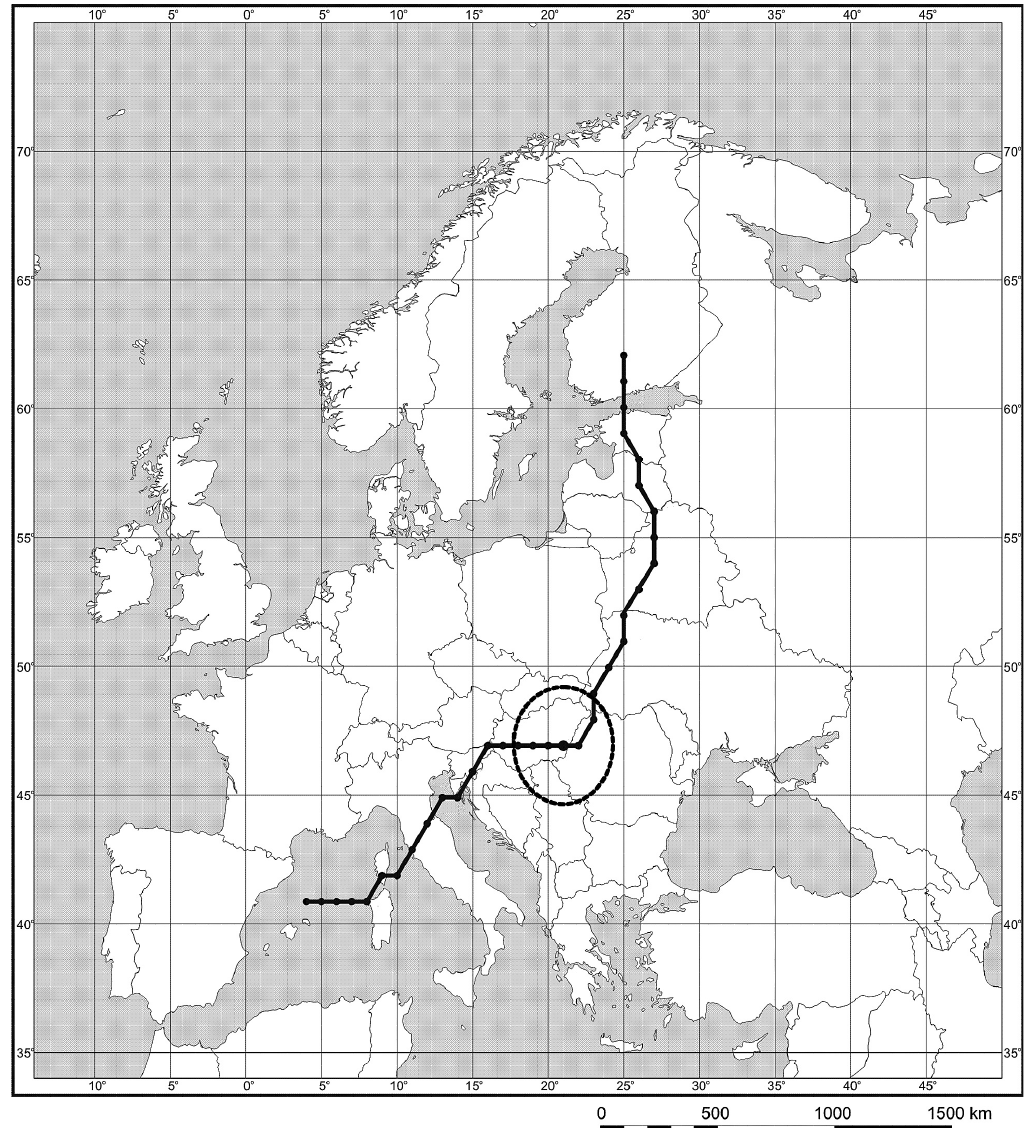
Fig. 3. Mean position of the track Vb of Mediterranean cyclones (MEC). Positions of cyclones involving the highest MCP in the area of Poland are delimited by a circle (after Degirmendžić et al.,